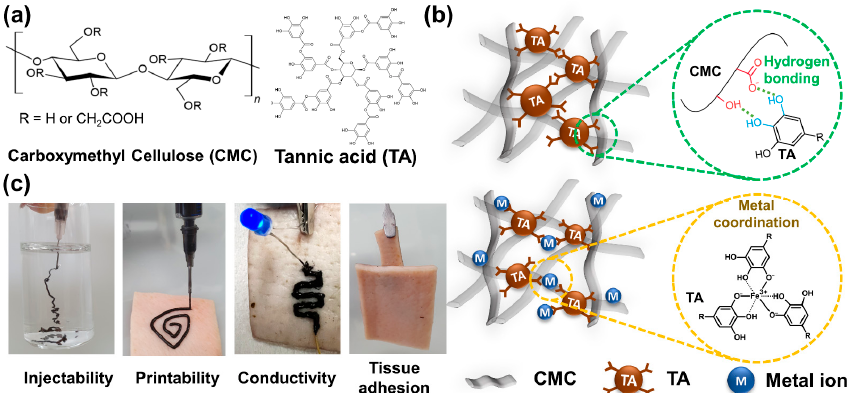
Figure 1. Schematic of the conductive adhesive CMC hydrogel. ( a ) Chemical structures of CMC and TA. ( b ) Fabrication mechanisms for the AC and CAC hydrogels. ( c ) Digital images of various properties of the CAC hydrogel.